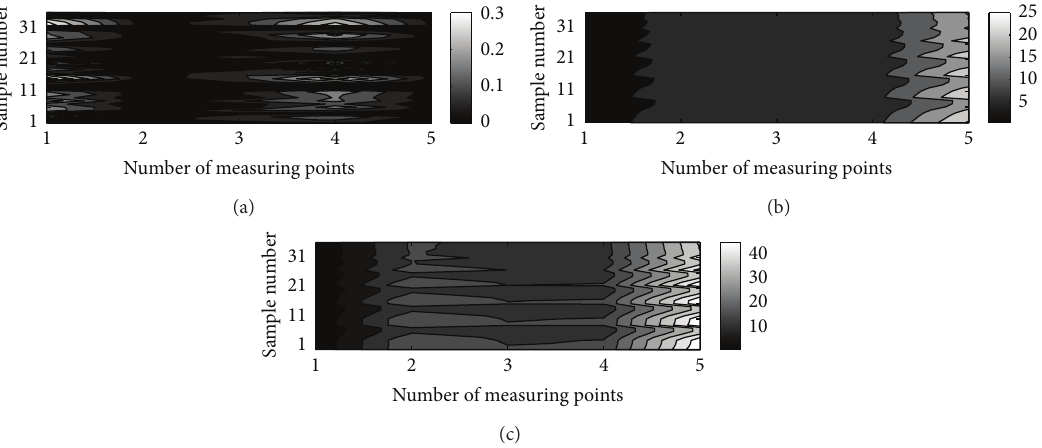
Figure 7: The SPE contribution plots of (a) case 2, (b) case 3, and (c) case 4.